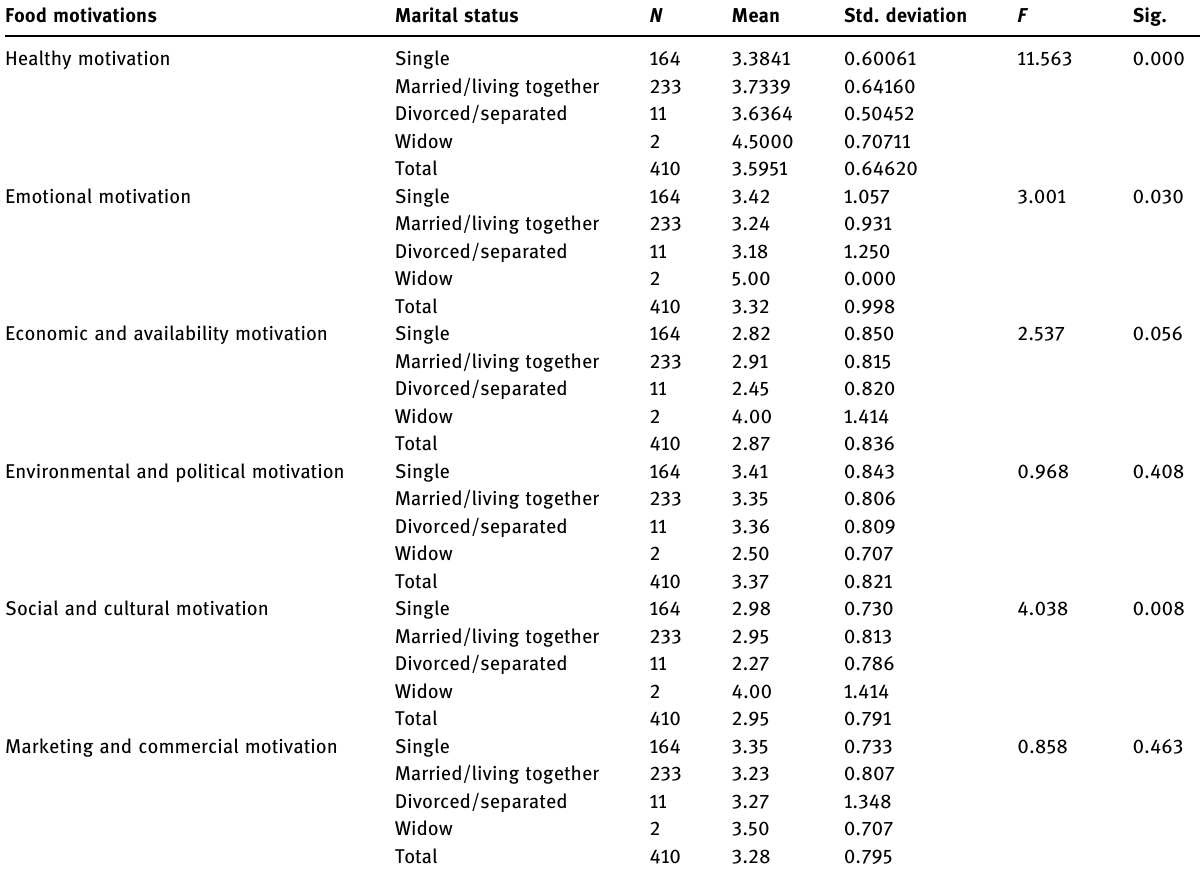
Table 6: ANOVA and mean results of civil status and food motivation factors Food